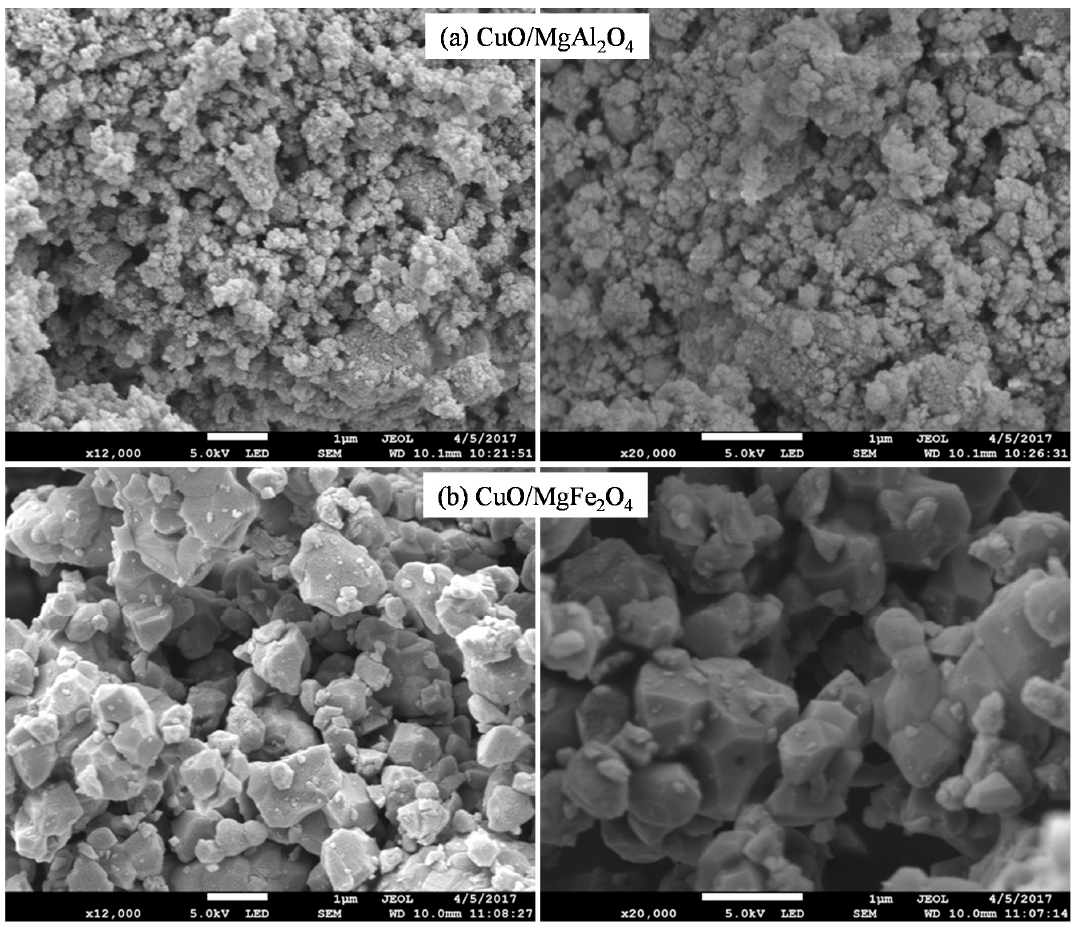
Figure 3. SEM images of synthesized nanocatalysts: ( a ) CuO/MgAl 2 O 4 , ( b ) CuO/MgFe 2 O 4.